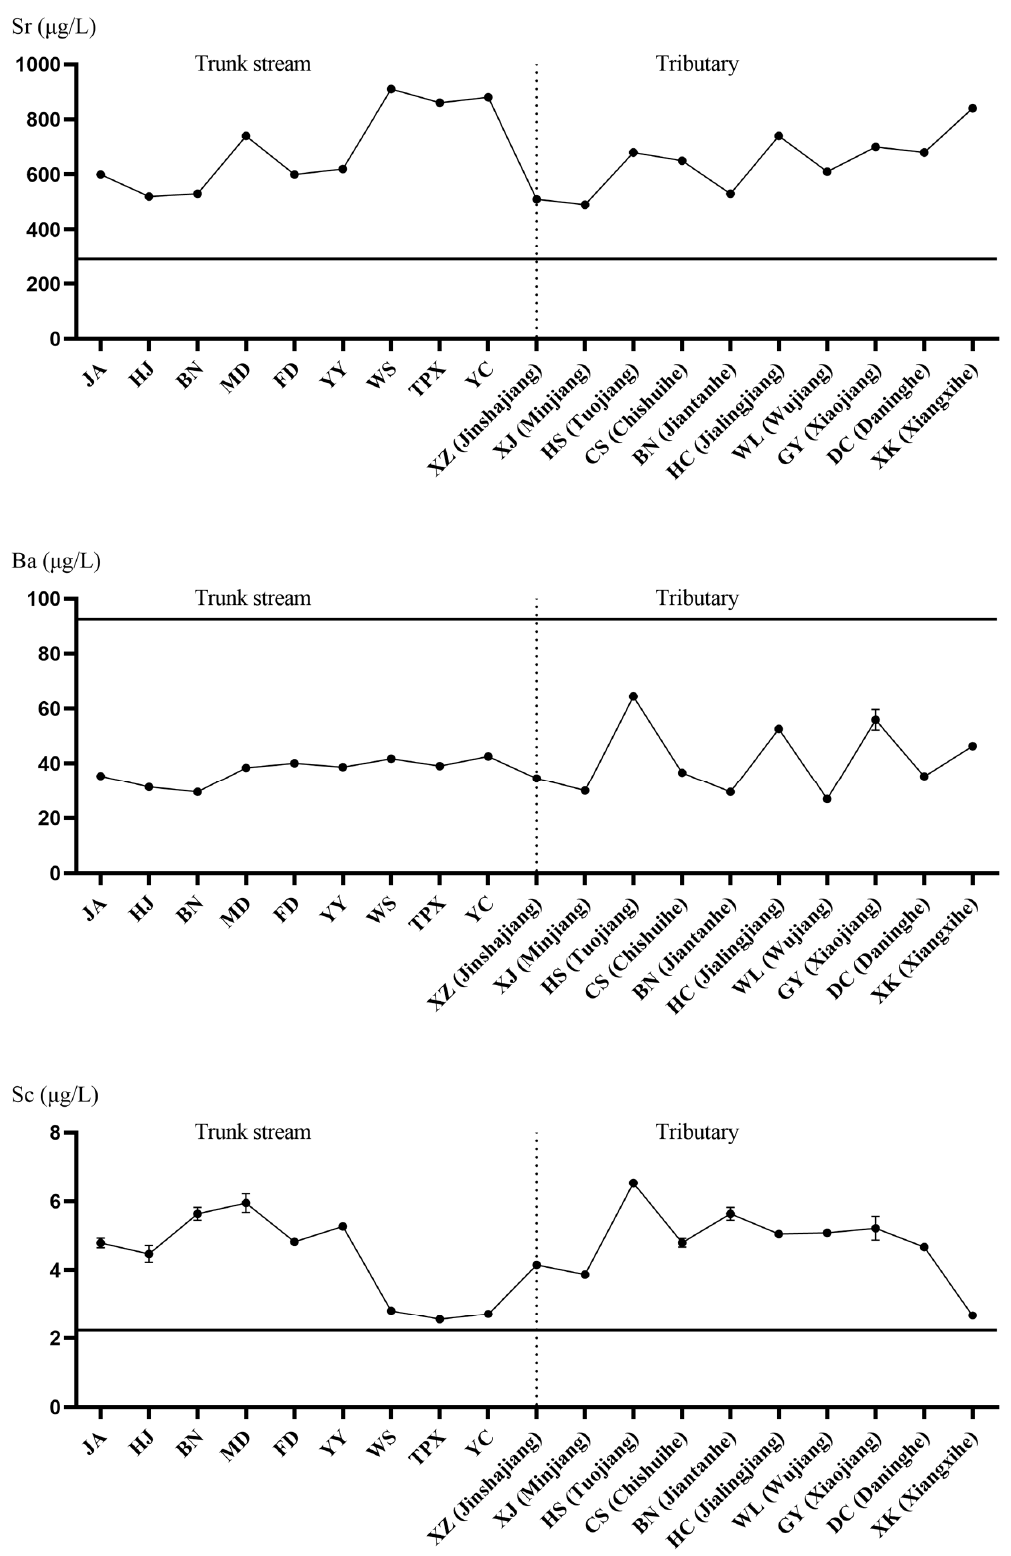
Figure 4. Spatial variance of Li, Sr, Ba and Sc ( µ g/L) concentrations in the sampling stations of the Yangtze River. The horizontal and solid lines in the figure represent the background values in historical documents. The x -axis is the sampling point. The left side of the vertical dotted line is the main stream and the right side is the tributaries of the Yangtze River; The y -axis is the element